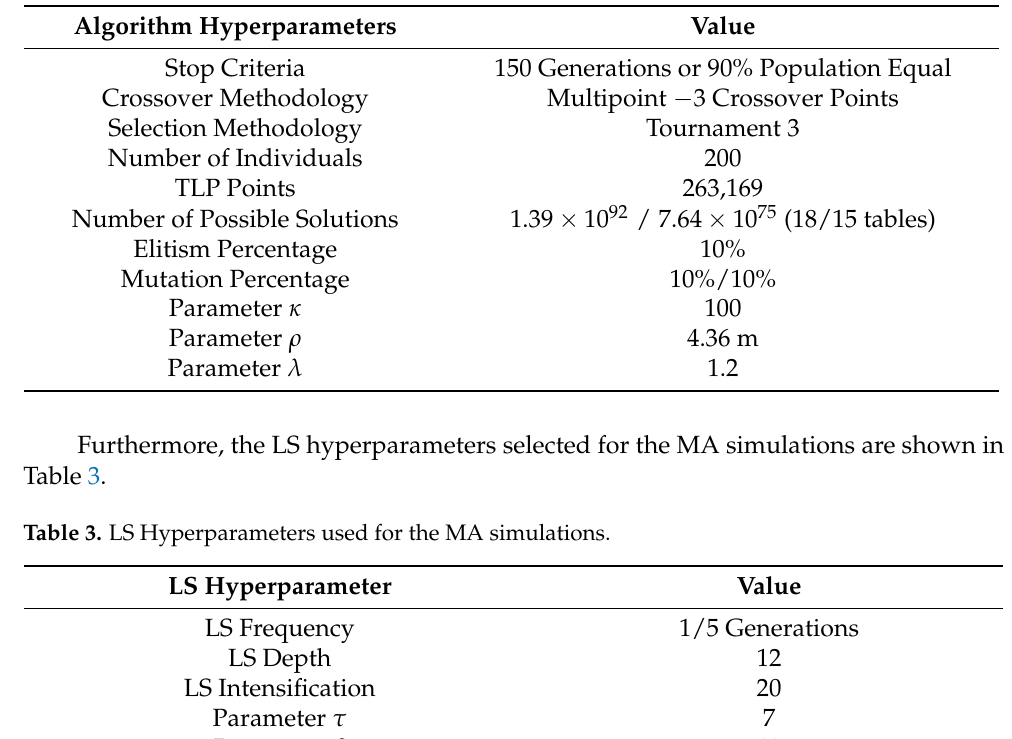
Table 2. MA and GA hyperparameters used for all the presented simulations. All values were adjusted experimentally based on the methodology introduced in [75].